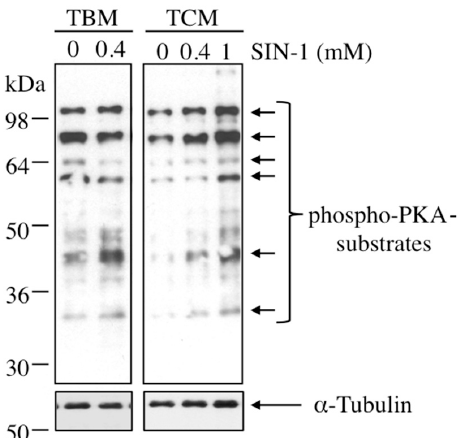
Figure 8. E ff ect of SIN-1 induced-peroxynitrite in the phosphorylation of PKA-substrates on boar spermatozoa. Spermatozoa were incubated in TBM or TCM medium at the indicated concentrations of SIN-1 at 38.5 ◦ C for 1 h and sperm proteins (15 µ g) analyzed by western blotting using anti-phospho-PKA-substrate as primary antibody (upper films). These experiments were performed